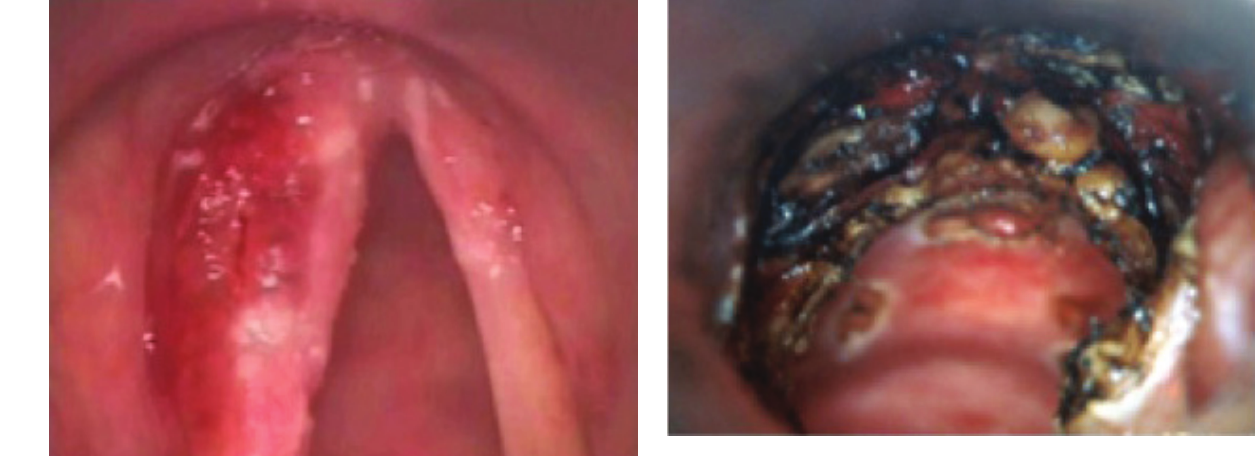
Figure 1: Fibrolaryngoscopy: red-violaceous nodular lesion of the left vocal cord and anterior commissure.